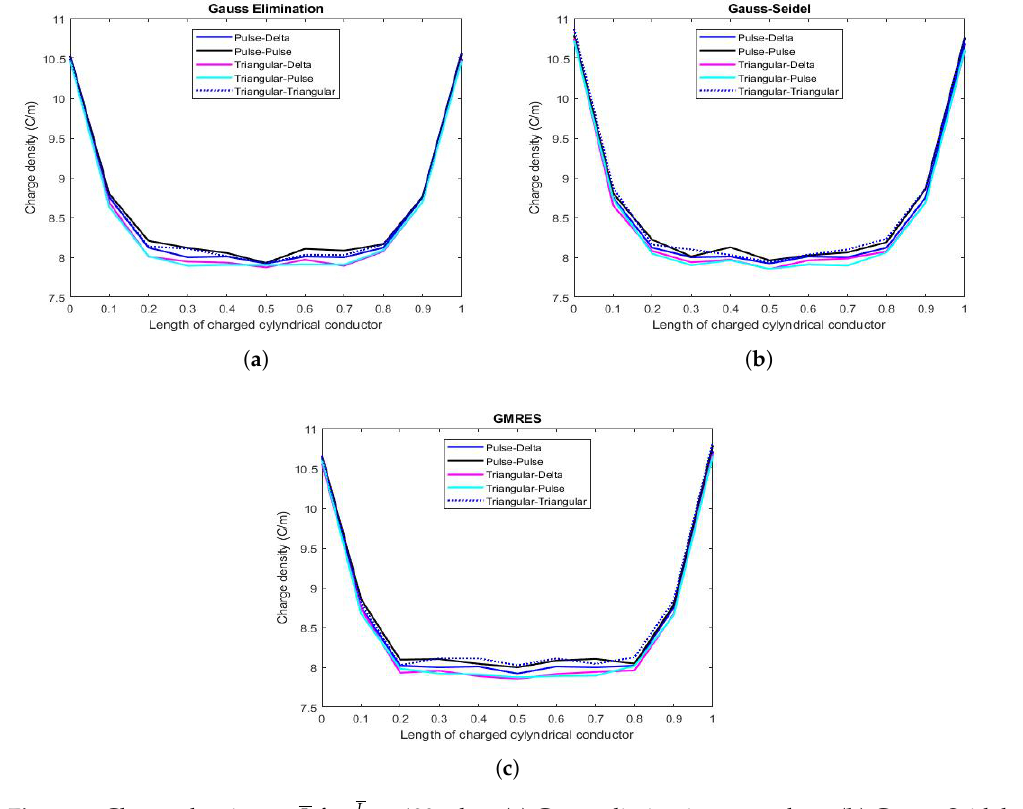
= 400 when ( a ) Gauss elimination procedure; ( b ) Gauss–Seidel Figure 7. Charge density vs. L for L d methods and ( c ) GMRES algorithm are exploited.